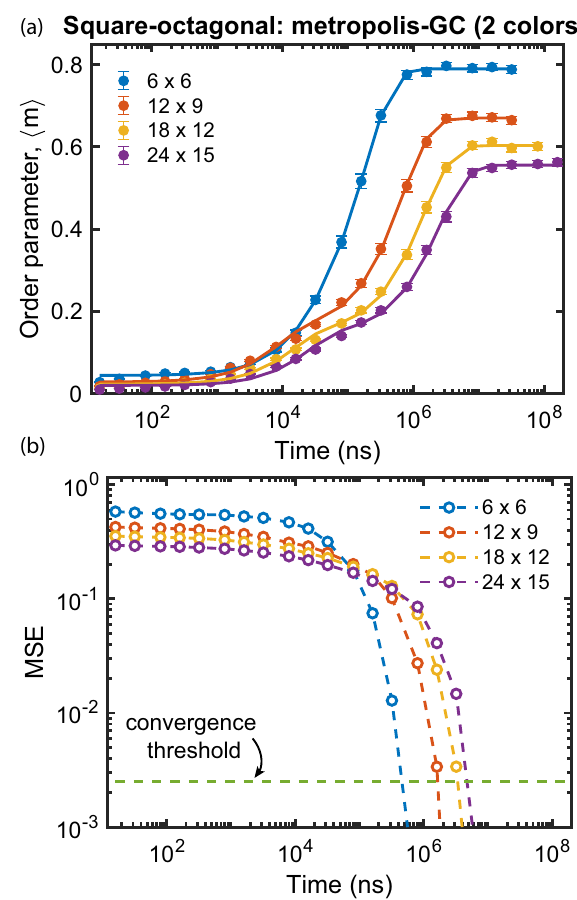
Fig. 3 Extracting convergence times from simulation results following the protocol described in ref. 36 . a Average order parameter 〈 m 〉 as de fi ned in Eq. (2) (Eq. (2) in ref. 36 ) are obtained for four different lattice sizes (blue: 6 × 6, red: 12 × 9, yellow: 18 × 12, purple: 24 × 15) using the mapped p-bit network. We have used Γ = 0.736, and β = 1/0.244 for which the scaling difference was reported to be maximum. We show results only for the counterclockwise wound initial condition as explained in the Supplementary Note 1. Only the curve labeled as 6 × 6 is obtained through actual fi eld programmable gate array emulation and the others are projected based on CPU simulation. All data points are averaged over 1000 different runs and the errorbars correspond to 95% con fi dence interval around the mean. Filled circles represent data points while the solid lines represent a exp ð(cid:2) bx Þ þ c exp ð(cid:2) dx Þ þ g type fi t. b Mean squared error (MSE) plot for each lattice size (blue: 6 × 6, red: 12 × 9, yellow: 18 × 12, purple: 24 × 15; hollow circles: data, dashed lines: fi t) calculated from their corresponding ` g ' values in a . The scaling is more clearly visible in this plot. Also shown is the 0.0025 threshold in dashed green which is used to de fi ne